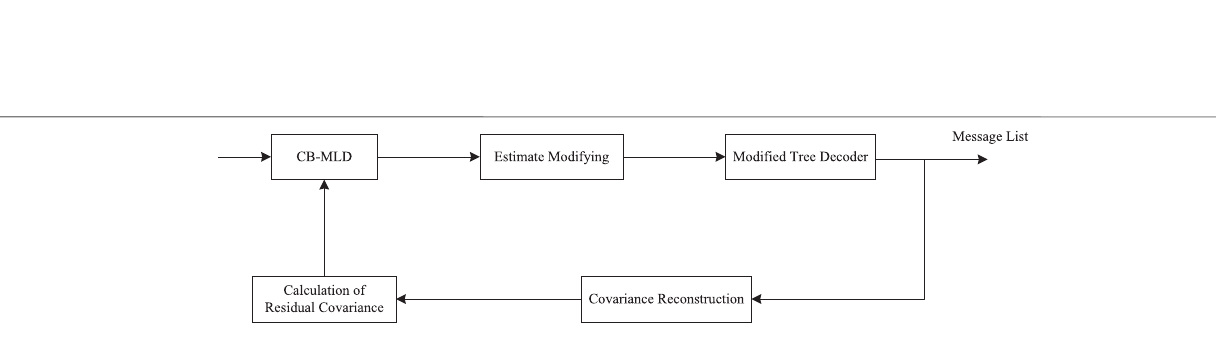
Frontiers in Communications and Networks |